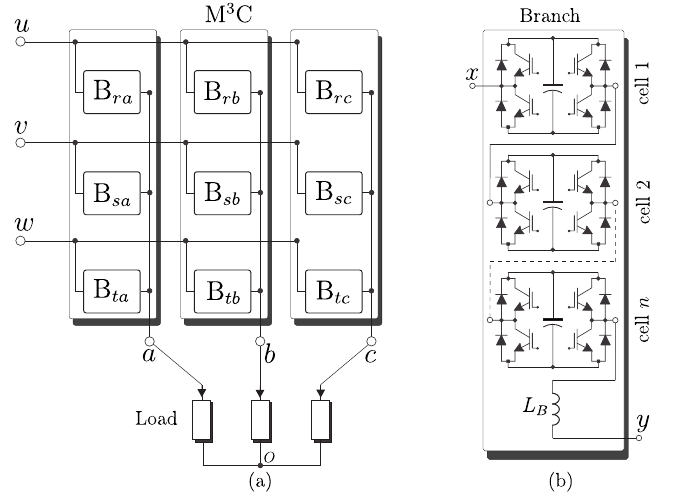
Figure 20. Modular multilevel matrix converter. ( a ) Generic M 3 C, ( b ) Branch composed by one inductor L B and n